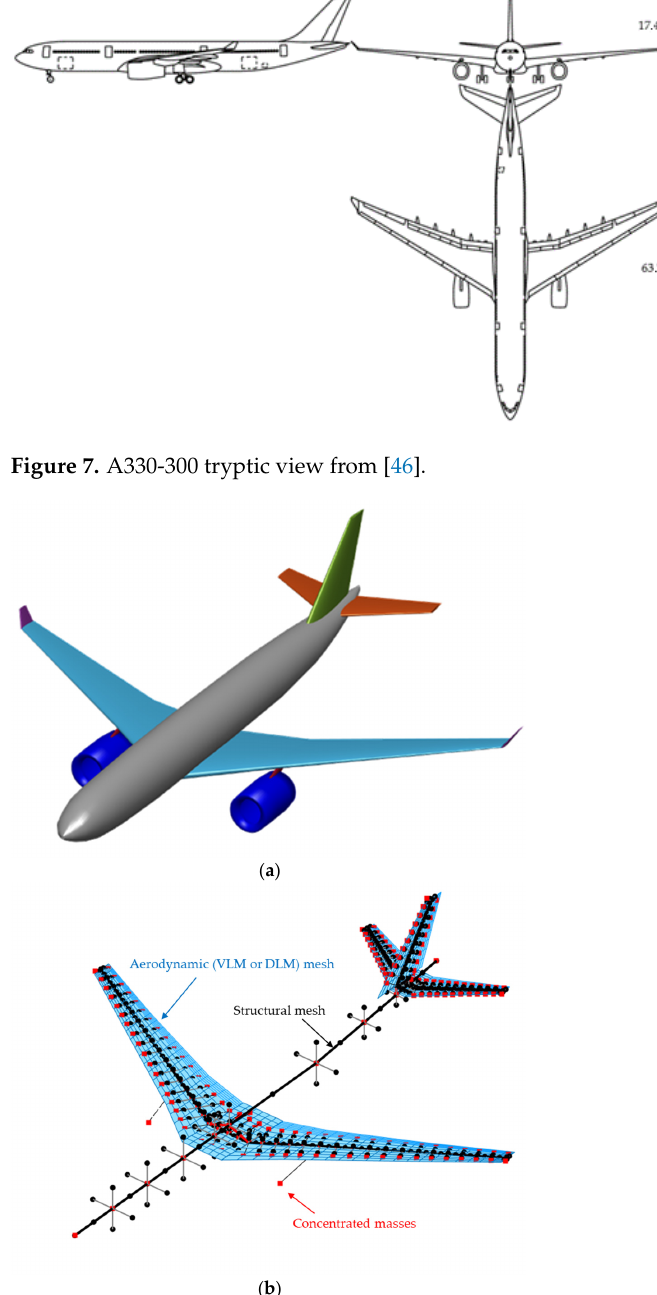
Figure 8. TALH models: ( a ) AcBuilder model; ( b ) stick aeroelastic model.